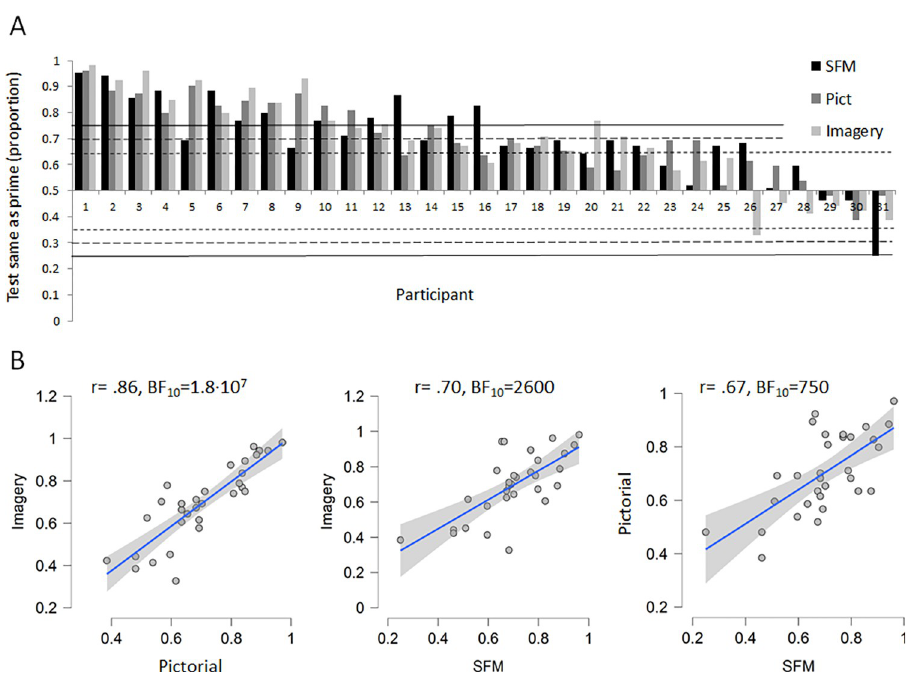
Fig 5. Influence of priming and correlations between prime conditions. (A) The order of participants is arranged from highest to the lowest average prime-effect across the three prime conditions. The bars show the proportion of responses where the test stimulus was perceived with the same orientation as the prime (out of 52 trials, .5 indicates no influence). Horizontal lines: p < .05; dotted line BF > 2; dashed lines BF > 10; solid lines BF > 100. (B) Pearson’s r and Bayes factors are shown in each scatterplot. All p’s < .001, tests are two-tailed. The shaded areas show the 95% CI of the regression lines.